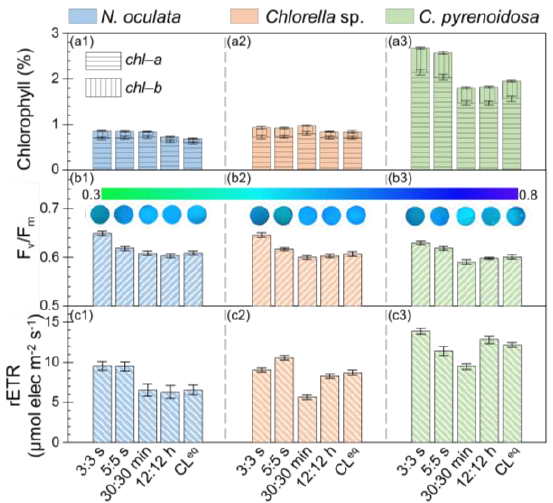
Figure 2. Chlorophyll content, maximal quantum yield ( F v / F m ), and relative electron transport rate (rETR) for microalgae biofilms: Nannochloris oculata ( a1, b1, c1 ), Chlorella sp. ( a2, b2, c2 ), and Chlorella pyrenoidosa ( a3, b3, c3 ).